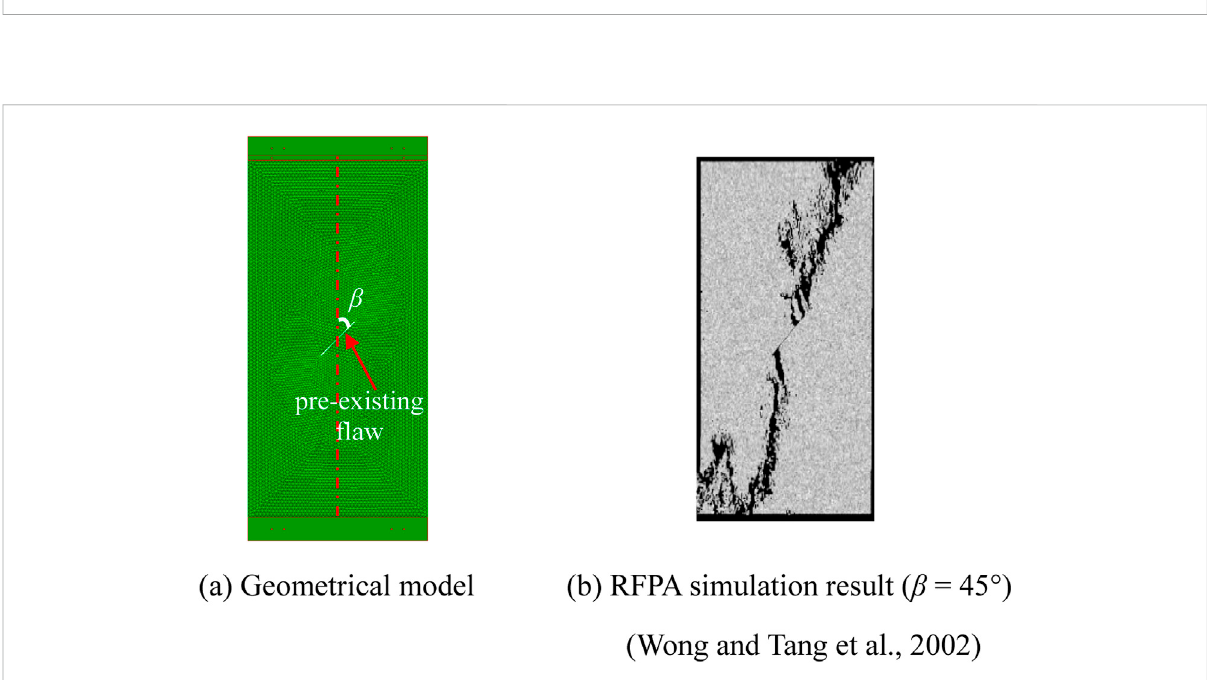
FIGURE 7 Geometrical model and RFPA simulation of a center-notched rectangular